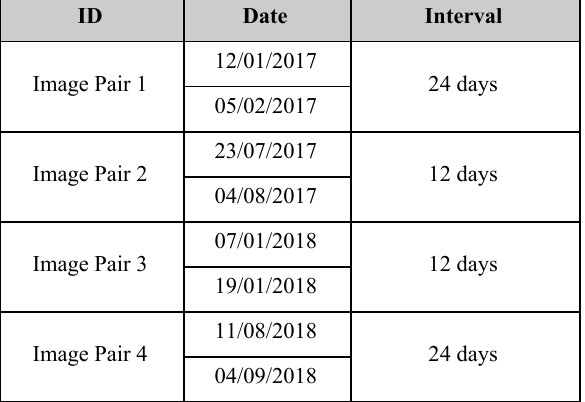
Table 1. Dates and intervals of SAR image